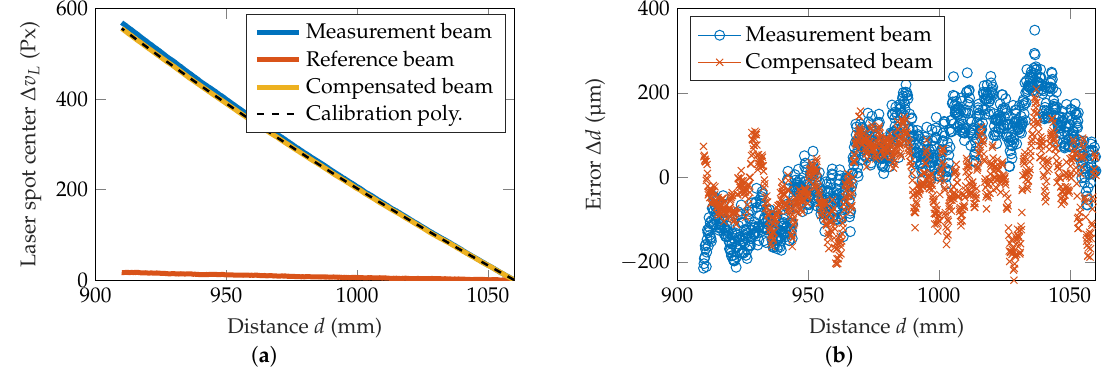
Figure 8. Dynamic measurement in a range of 150mm. ( a ) Comparison of the measurement, reference and compensated beam position. ( b ) Measurement deviation for the measurement and compensated